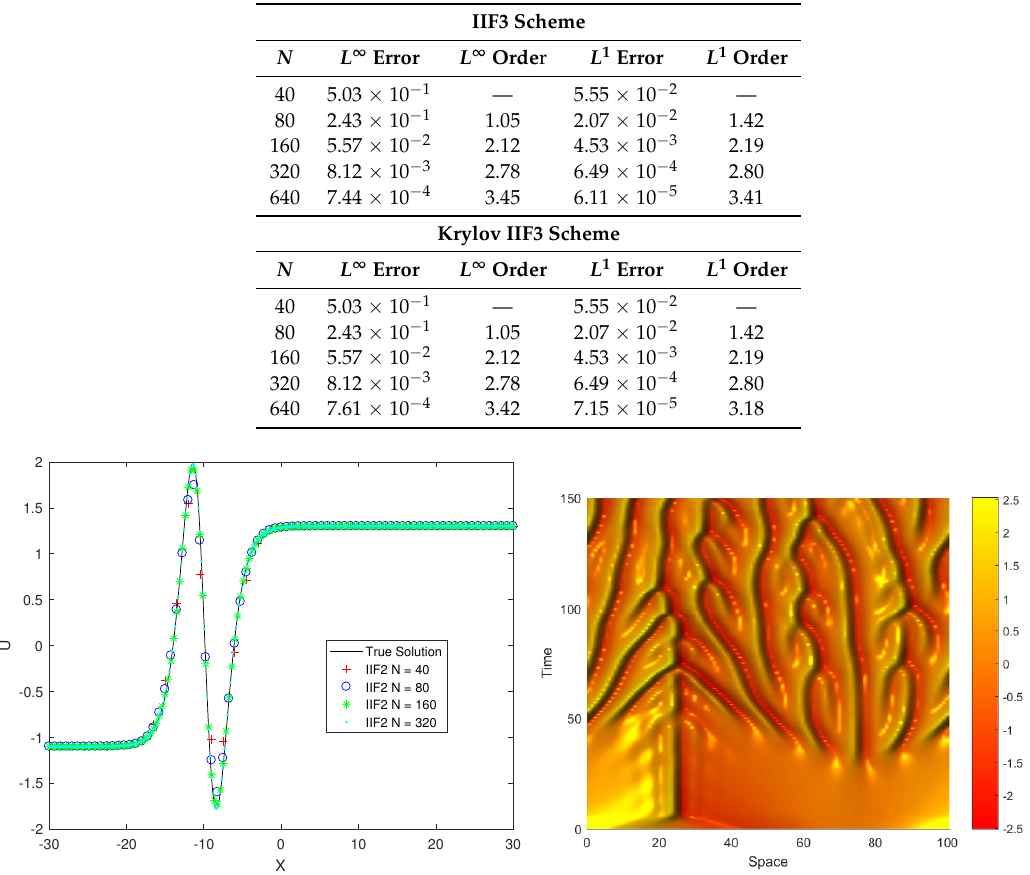
Figure 2. Example 2. Kuramoto–Sivashinsky (KS) equations. Spatial discretizations: the third-order WENO scheme for the advection term; the second-order central schemes for diffusion terms. Left picture: numerical solutions of Equation (29) using the IIF2 scheme with N = 40,80,160,320; final time: T = 1.0; CFL number for the hyperbolic term: 0.5. Right picture: time evolution for Equation (32) solved using the Krylov IIF2 scheme with M = 25; N = 128; CFL number for the hyperbolic term: 0.1; time runs from t = 0 at the bottom of the picture to 150 at the